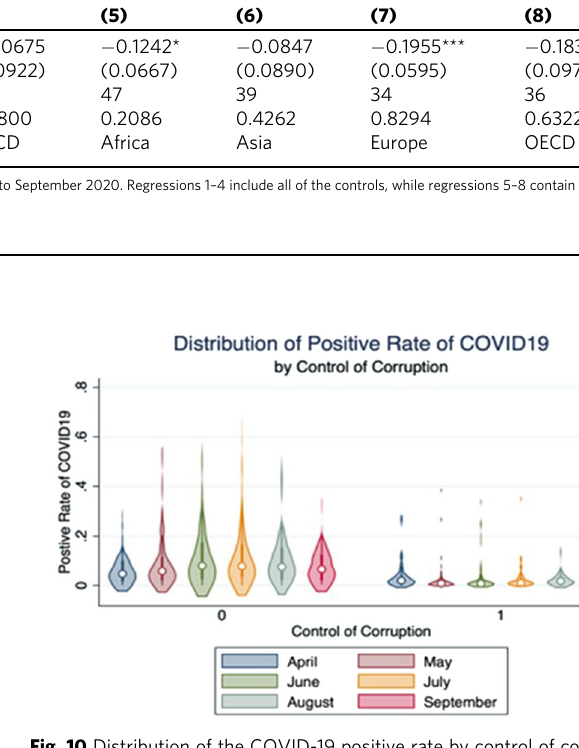
Fig. 8 Distribution of the COVID-19 positive rate by rule of law.